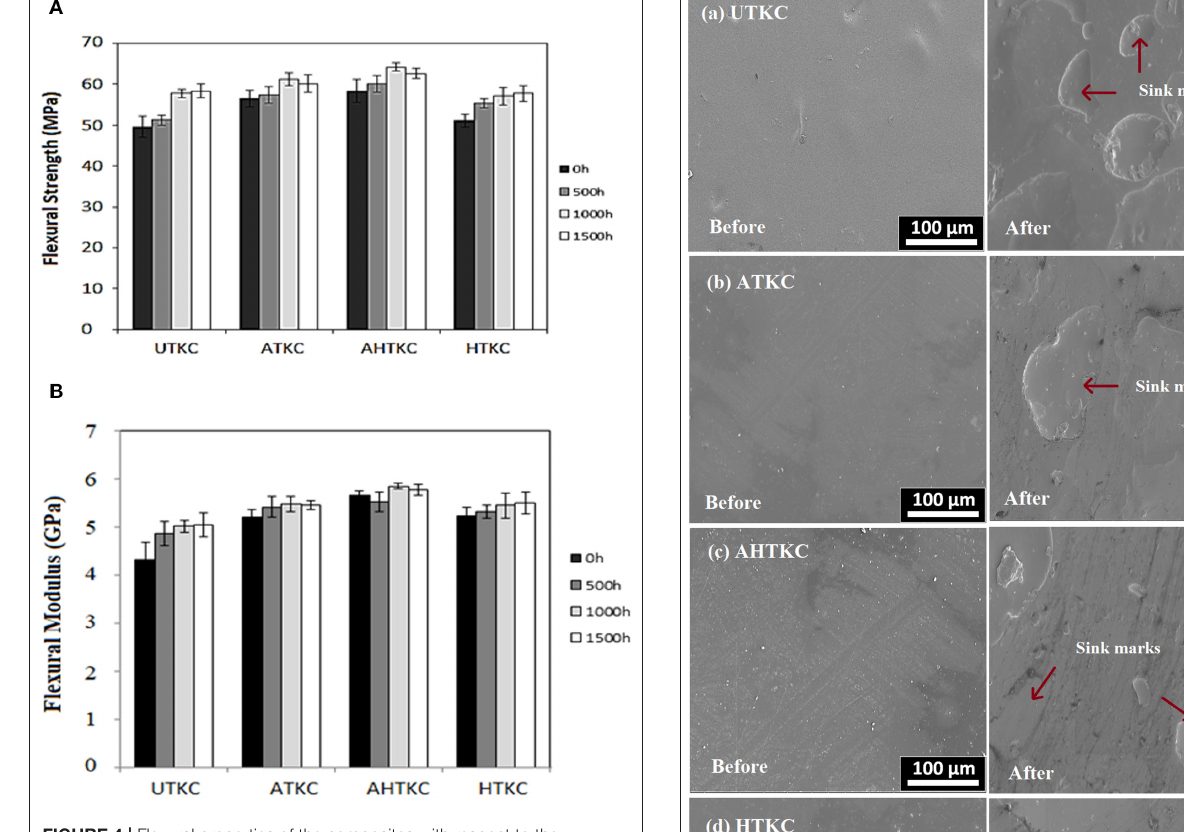
FIGURE 4 | Flexural properties of the composites with respect to the accelerated weathering exposure time (A) flexural strength and (B) flexural modulus.